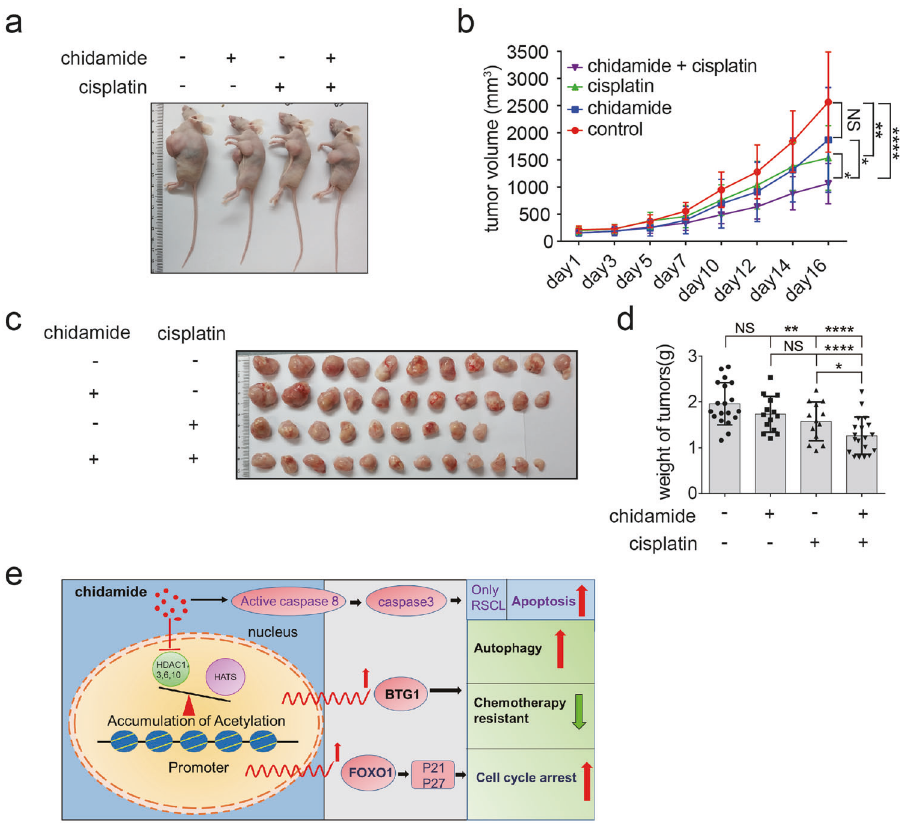
Fig. 8 Chidamide and chemotherapeutics are synergetic in vivo. a – d Nude mice were subcutaneously with Raji-4RH cells in both fl anks, after tumor volume is about 5 × 5 × 5 mm. These mice were randomly divided into 4 groups and treated with the combination of chidamide (25 mg/kg) and cisplatin (1 mg/kg) for about 2 weeks. Volumes of each group were shown in body ( a ) and growth curve ( b ). The weights c and sizes d of tumors were analyzed after sacri fi ce of mice. e Chidamide treatment caused the accumulation of histone acetylation at the promoter regions of FoxO1 and BTG1. Upregulation of FOXO1 increased the expression of p21 and p27, and induced cell cycle arrest. Above all, increased expression of BTG1 caused cell autophagy and decreased chemotherapeutics resistant ( N = 3). For all graphs, data are presented as mean ± SD, * p < 0.05, ** p < 0.01, p < 0.005***, p < 0.001****. Statistical analysis was performed with a paired t